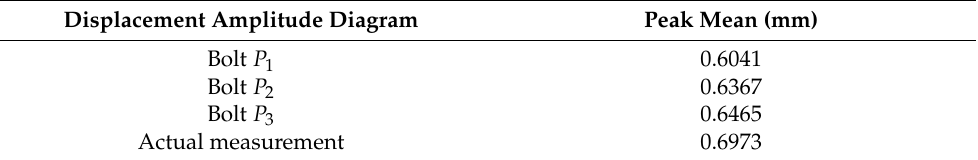
Figure 18. Spectrum comparison diagram. Table 6. Peak mean values of displacement amplitudes of different displacement images.